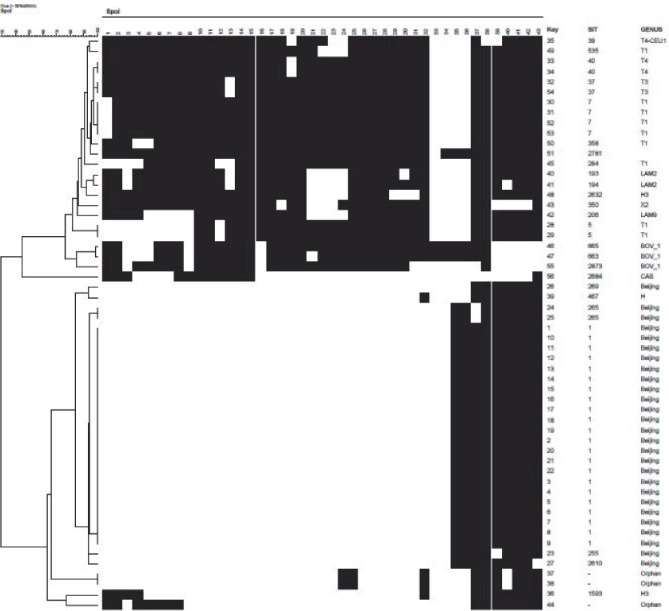
Cluster analysis diagram of the spoligotyping results for the 56 MTB strains.